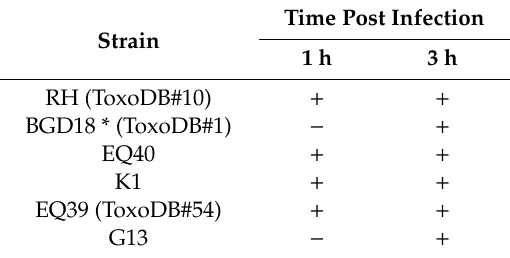
Table 4. In vitro invasion kinetics ( + denotes the presence of infected cells, − denotes absence). Strain